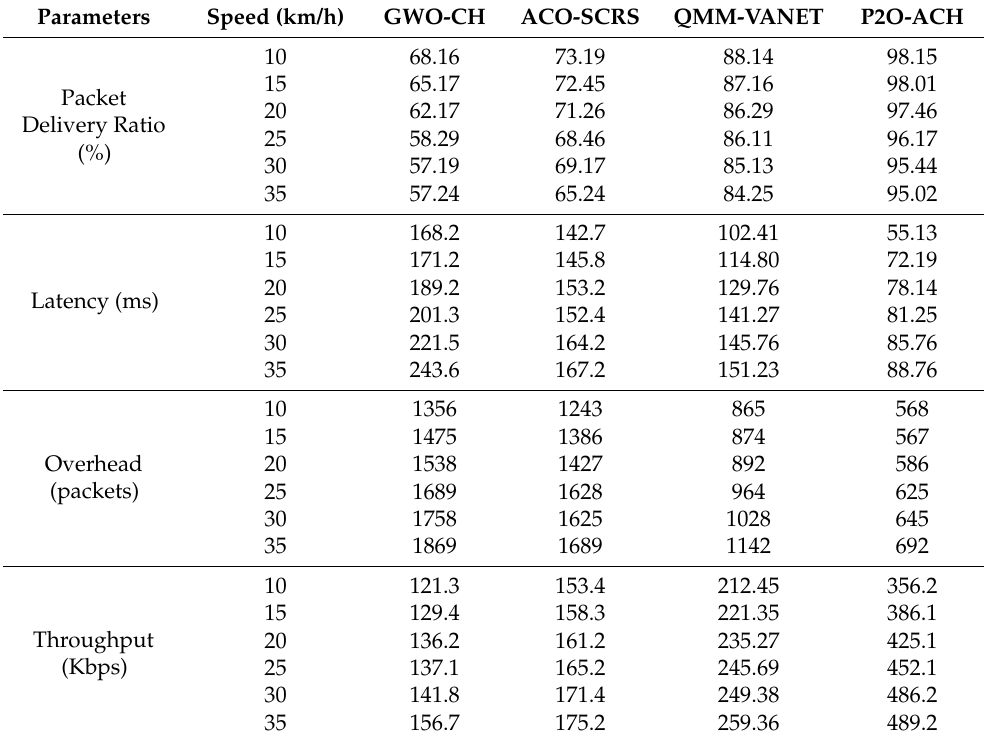
Table 10. Performance Analysis of Packet Delivery Ratio, Latency, Routing Overhead, and Through- put in Terms of Varying